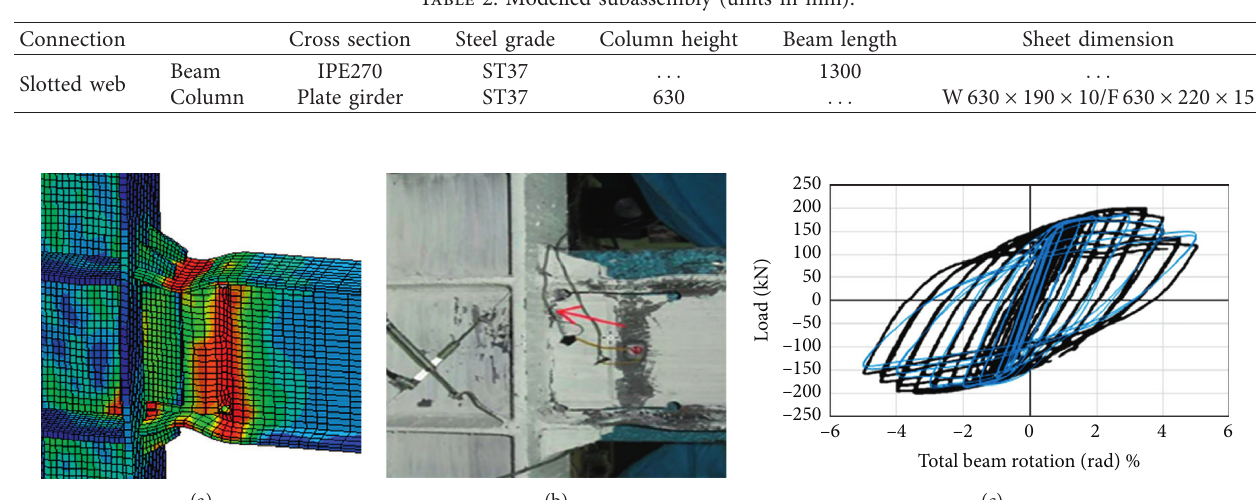
Figure 12: Comparison of the FE model and test results of specimen SW tested by [6]. (a) Test [3]. (b) Modelled specimen. (c) Hysteresis responses.